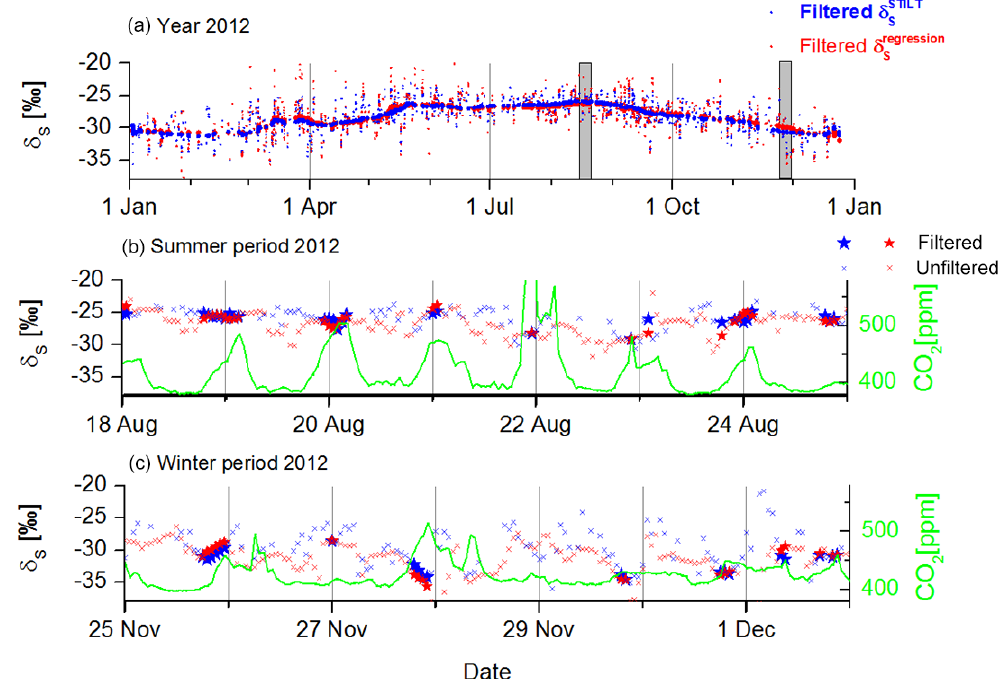
Figure 3. Comparison between modeled reference source signature (blue) and the moving Keeling plot intercept (red), which is regression- based using the modeled CO 2 and δ 13 C(CO 2 ) records. (a) Long-term comparison for the year 2012. The smoothed lines of window size 100 are also shown in the respective colors. (b) Summer excerpt and (c) winter excerpt (gray areas in a ) of both reference and regression- based source signature. The crosses denote unfiltered data, and bold stars denote filtered data. The green lines in panels (b) and (c) give the measured CO 2 concentration during the summer and winter periods,